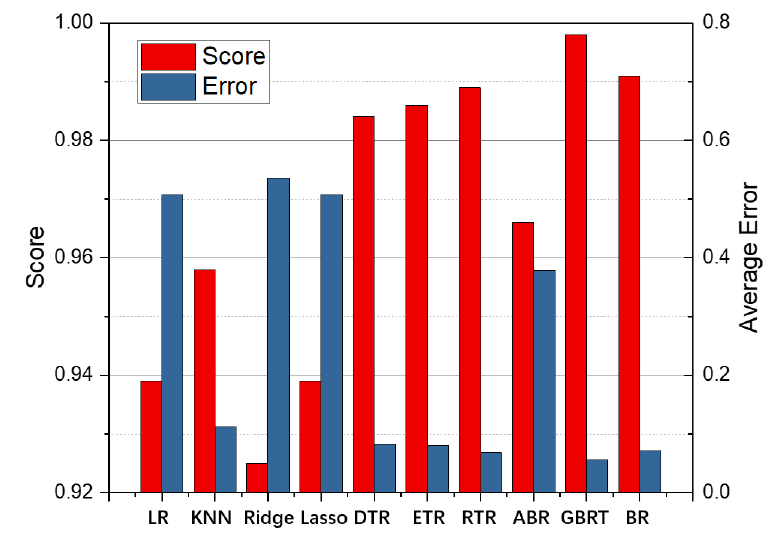
Figure 4. The score and the average error of each model.